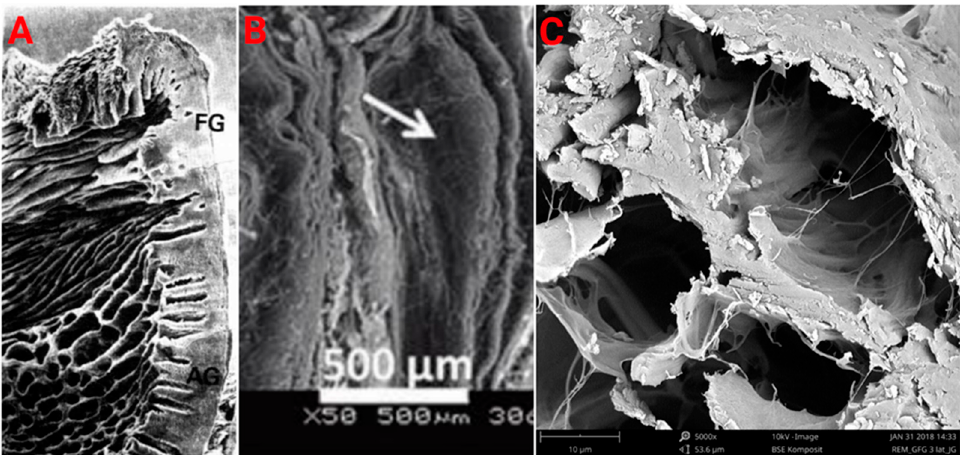
Figure 4 . Scanning electron microscopy images of different gingival tissue and previously reported constructs. ( A ) Scanning electron microscopy images of native gingival tissue. FG: free gingival, AG: attached gingiva. Reproduced with permission [68]. Copyright 1981, published by the Journal of Periodontal Research. ( B ) Scanning electron microscopy images of layered poly(l-lactic acid) electrospun scaffolds with adipose-derived stem cells and collagen. The white arrow indicates delamination of the scaffold layers. Reproduced with permission [70]. Copyright 2010, published by the Tissue Engineering—Part C: Methods. ( C ) Scanning electron microscopy images of a Geistlich ® Fibro-Gide ® matrix. Copyrights by courtesy of Geistlich Pharma AG.